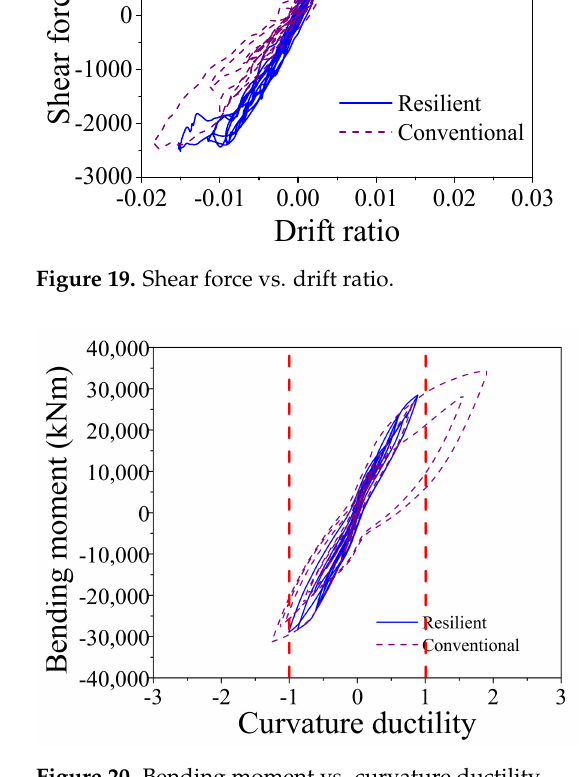
Figure 20. Bending moment vs. curvature ductility.